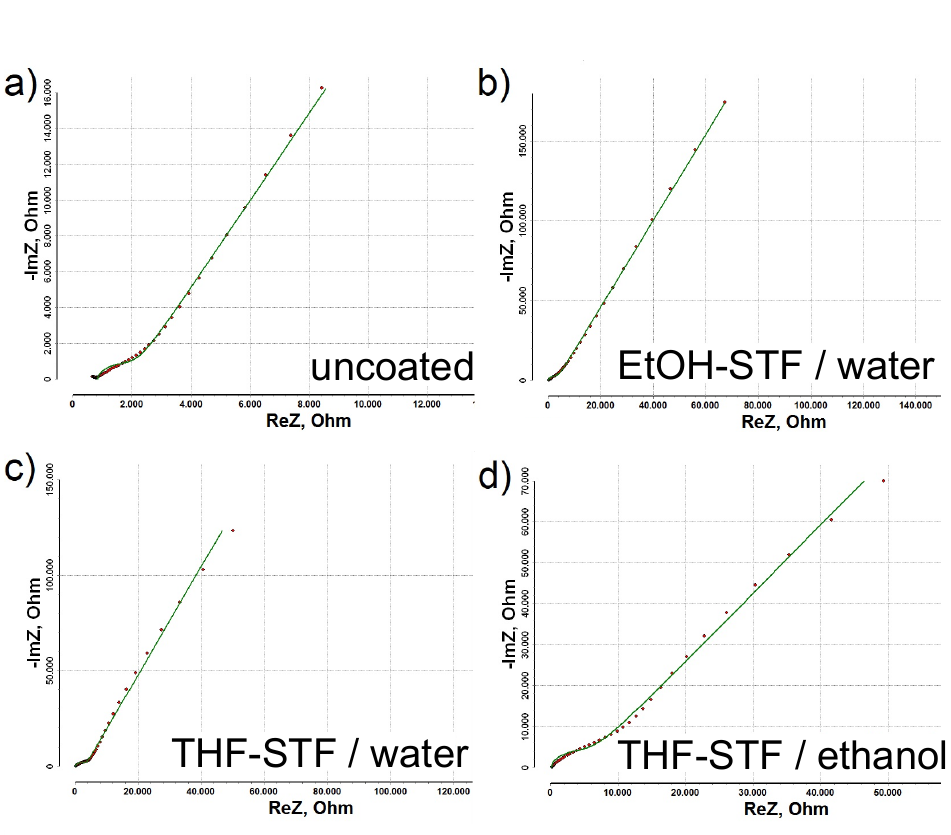
Figure A2. Equivalent circuit fit (lines; cf. Figure 1d) of the experimental EIS spectra (points) for ( a ) uncoated WE exposed to water, ( b ) EtOH-STF-coated WE exposed to water, ( c ) THF-STF-coated WE exposed to water, and ( d ) THF-STF-coated WE exposed to